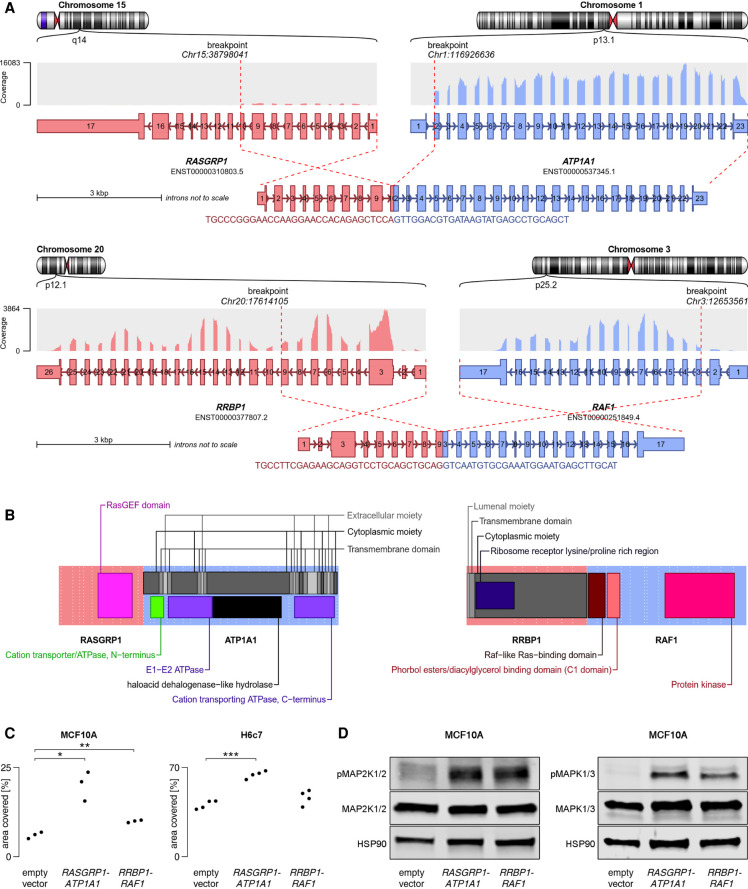
Structural and functional characteristics of RRBP1-RAF1 and RASGRP1-ATP1A1. (A) Structure of the fusion transcripts. (B) Protein domains retained in the fusion proteins and topology. Near full-length RAF1 was found to be fused to the transmembrane protein RRBP1, presumably tethering RAF1 to the endoplasmatic reticulum with its kinase domain facing the cytoplasmic space. The oncogene RASGRP1 was predicted to be fused to ATP1A1, a protein embedded in the plasma membrane. Although oncogenes are more often found to constitute the C terminus of a fusion protein, RASGRP1 appeared to be fused to the N terminus of ATP1A1, thereby replacing several C-terminal domains of RASGRP1, which normally regulate recruitment to the plasma membrane, where RASGRP1 activates its target, KRAS (Beaulieu et al. 2007). Presumably, replacement of these regulatory domains by a membrane-bound protein increased the activity of RASGRP1 by means of warranting proximity to KRAS. (C) MCF10A and H6c7 cells were stably transduced with one of the fusion constructs or empty vector. MCF10A cells were cultured for 8 d without EGF, H6c7 cells were cultured for 7 d with EGF, and the area covered by cells was measured. Statistical significance was tested using a two-sided Welch t-test (MCF10A RASGRP1-ATP1A1: P-value = 0.023; MCF10A RRBP1-RAF1: P-value = 0.0094; H6c7 RASGRP1-ATP1A1: P-value = 4.1×10−5; H6c7 RRBP1-RAF1: P-value = 0.14). (D) Western blot showing increased phosphorylation of MAP2K1/2 (MEK1/2) and MAPK1/3 (ERK2/1) in TP53-deficient MCF10A cells stably transduced with one of the fusions as compared to empty vector.